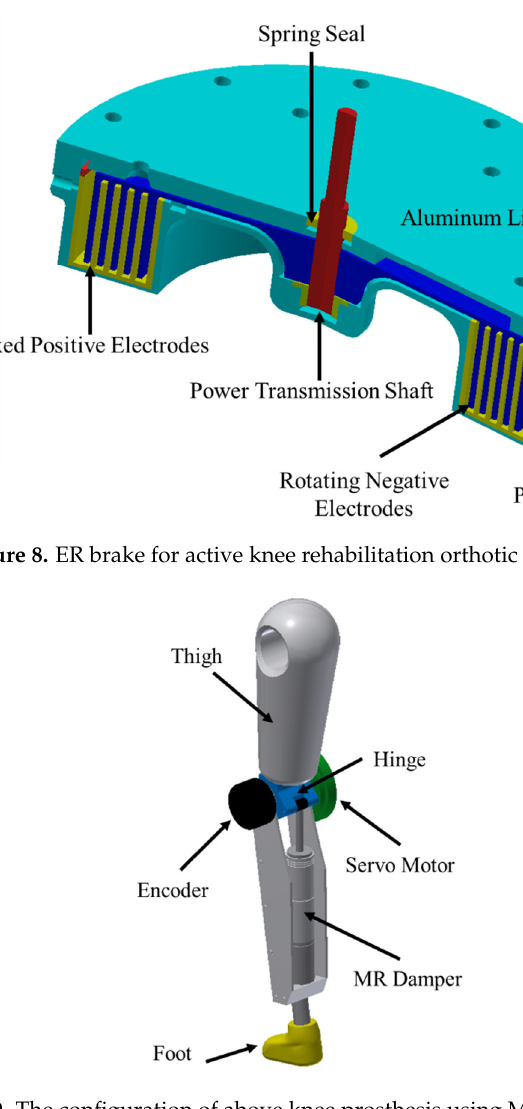
Figure 10. T-shaped MR brake for portable wrist rehabilitation device [88].